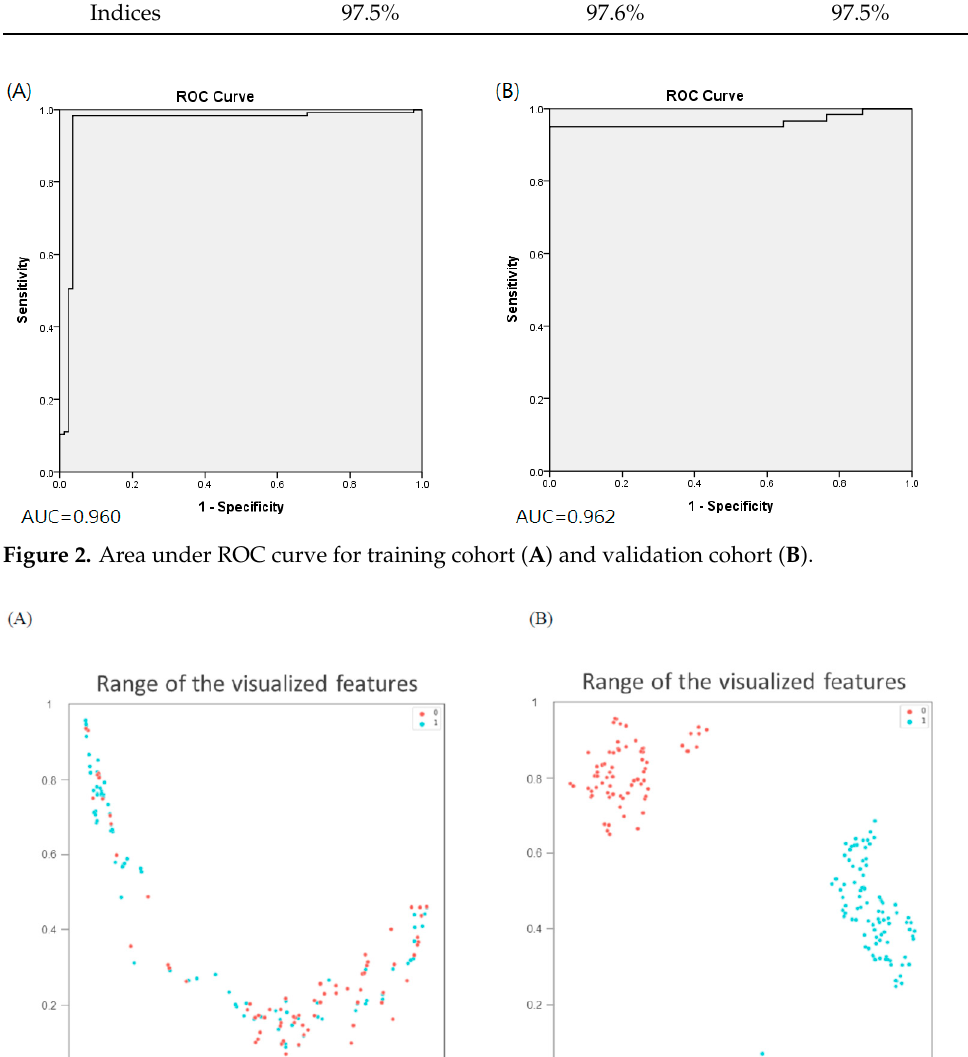
Figure 4. Classification performance of training cohort by support vector machine for tumor regres- sion grade 3 or 4 responses following dimensionality reduction of visualized features. Blue spots represent tumor regression grade 3 or 4 responses; red spots correspond to responses lower than grade 3.